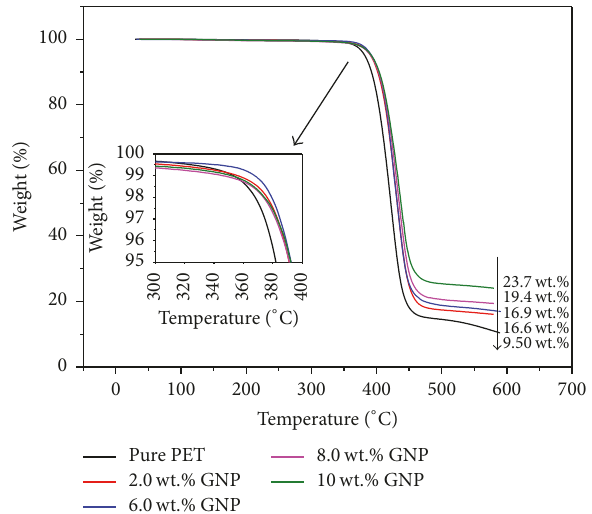
Figure 10: TGA thermograms of nanocomposites examined under nitrogen atmosphere.